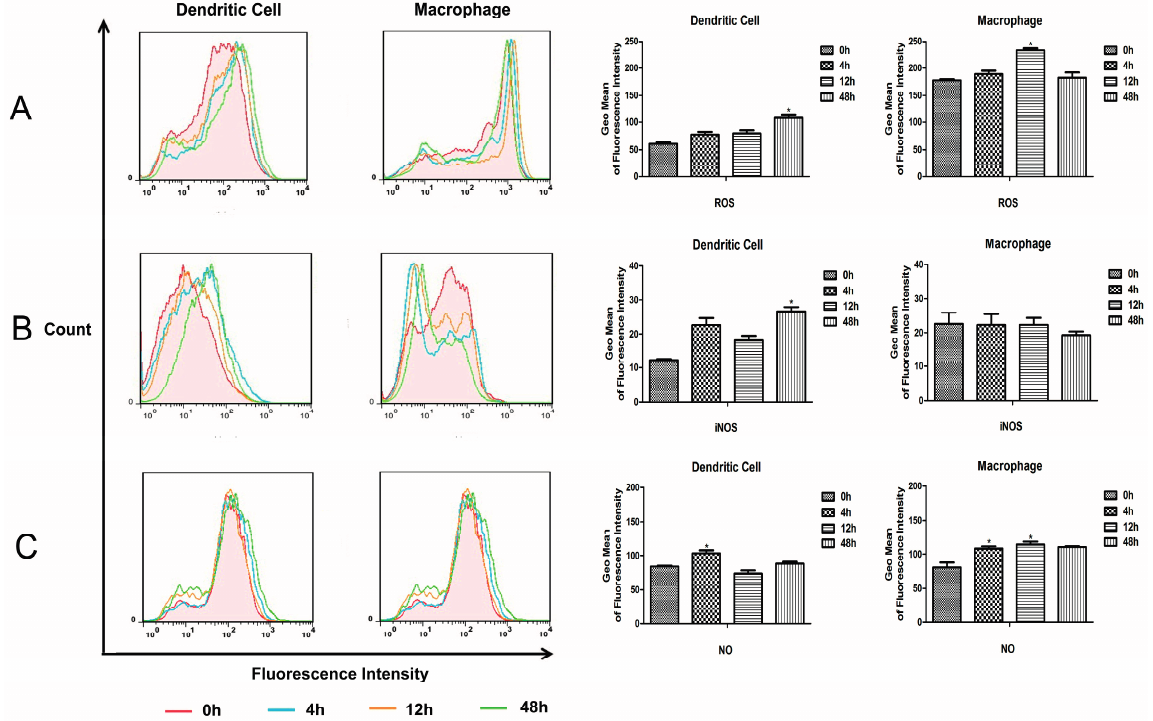
Figure 3. Detection of ROS, iNOS and NO of murine splenic M Φ s and DCs. The intracellular ROS ( A ), iNOS ( B ) and NO ( C ) produced in murine splenic M Φ s and DCs after M.bovis BCG infection were detected. Data depicted represent the mean values ± SEM. Statistical significance was determined by a Student’s t -test ( * p <